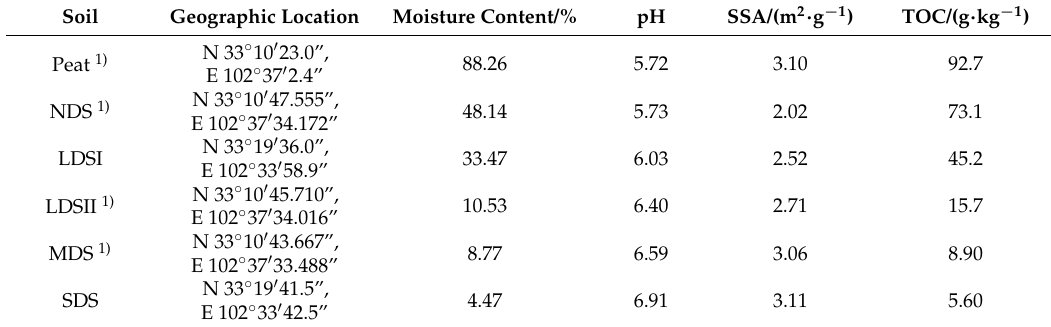
Table 1. The basic physicochemical properties of the six tested pristine soils.